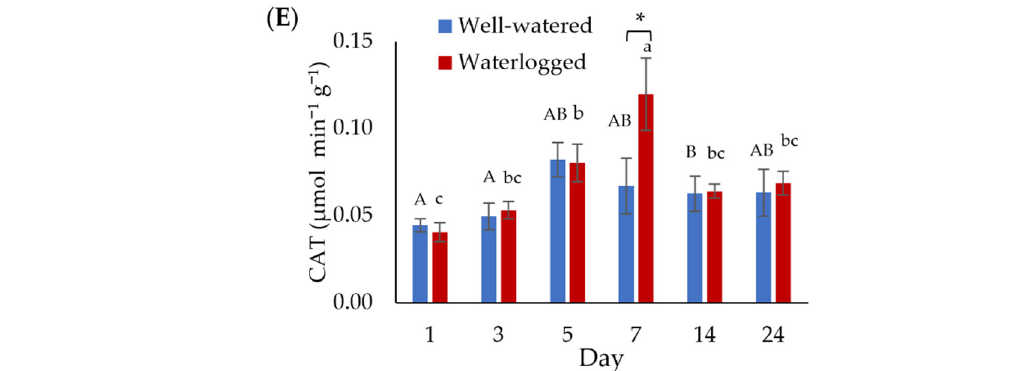
Figure 4. Activities of ( A ) superoxide dismutase (SOD), ( B ) ascorbate peroxidase (APX), ( C ) glutathione reductase (GR), ( D ) glutathione peroxidase (GPX), and ( E ) catalase (CAT) in banana plants in response to waterlogging. Error bars indicate the standard error of nine independent replications with three technical replicates each. Different capital letters indicate a significant difference between time points within well-watered samples. Different lowercase letters indicate a significant difference between time points within waterlogged samples. Asterisks (*) indicate a significant difference between well-watered and waterlogged samples at the same time point ( p < 0.05).